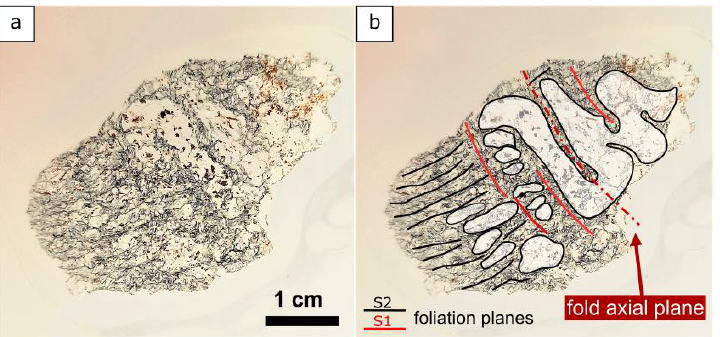
Figure 7. Thin section perpendicular to the fault slip, showing a folded quartz vein. ( a ) Uninterpreted photo; ( b ) Interpreted photo showing the two different foliations, S1 and S2. The quartz vein is partially overprinted by the younger S2 foliation (during D2, black lines), perpendicular to the fold axial planes (S1/D1, red lines).